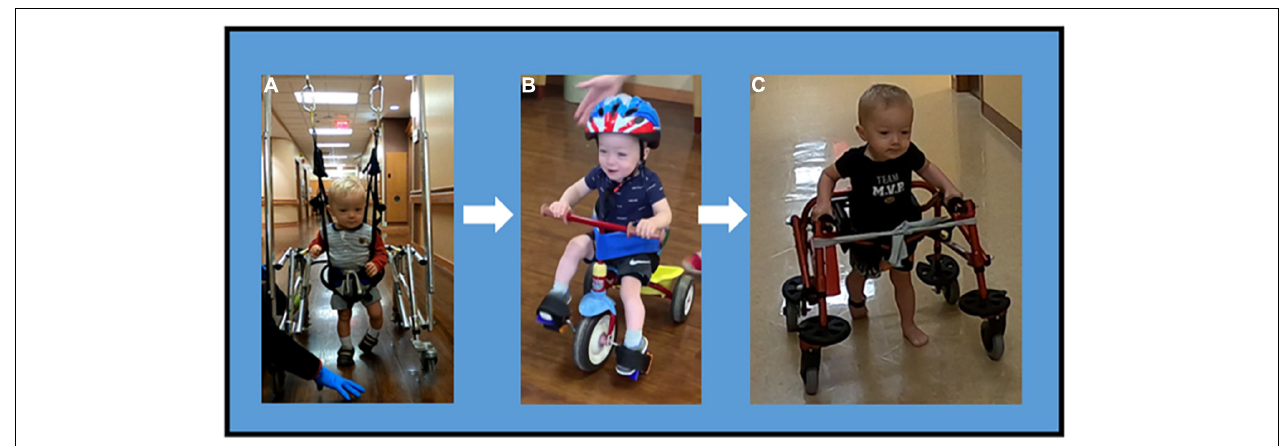
FIGURE 4 | Mobility progression. Mobility Progression over time during ongoing course of activity-based restorative therapy. (A) Ambulation was initiated with use of a walker, harness and body weight support. The patient required assist for propulsion and continued to demonstrate a scissoring gait pattern with genu recurvatum and excessive plantarflexion. (B) At session 90, the patient can independently propel a tricycle with adaptations for pelvic alignment, for safety (seat belt) and foot strapping. (C) Patient progressed to independent reciprocal stepping in a reverse rolling walker with hip guides and sling seat. This is the primary means of